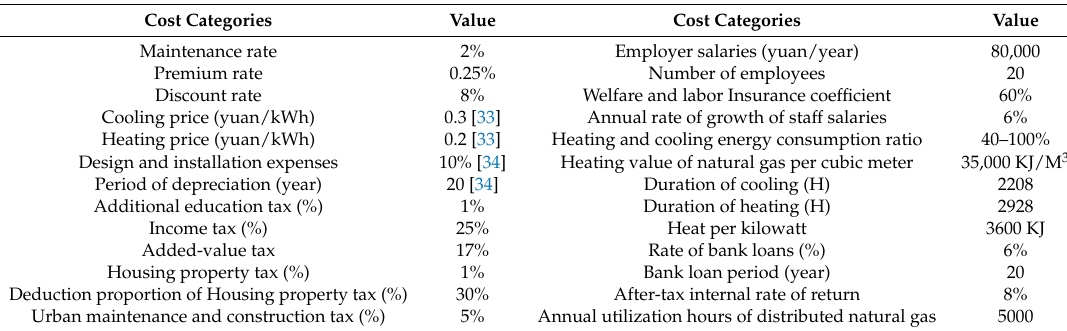
Table 7. Some parameter values in the